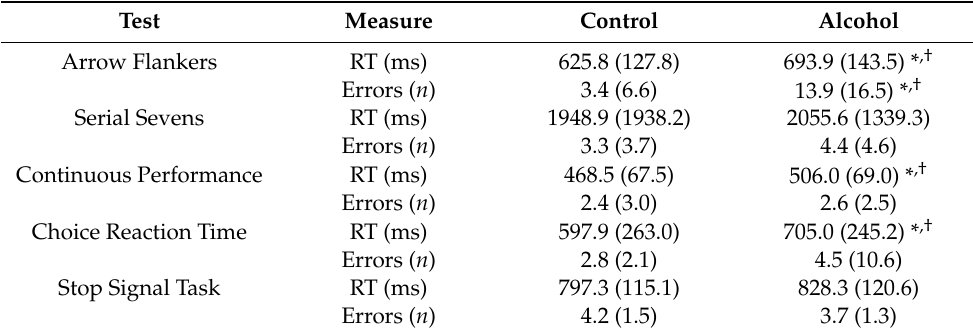
Table 2. Performance